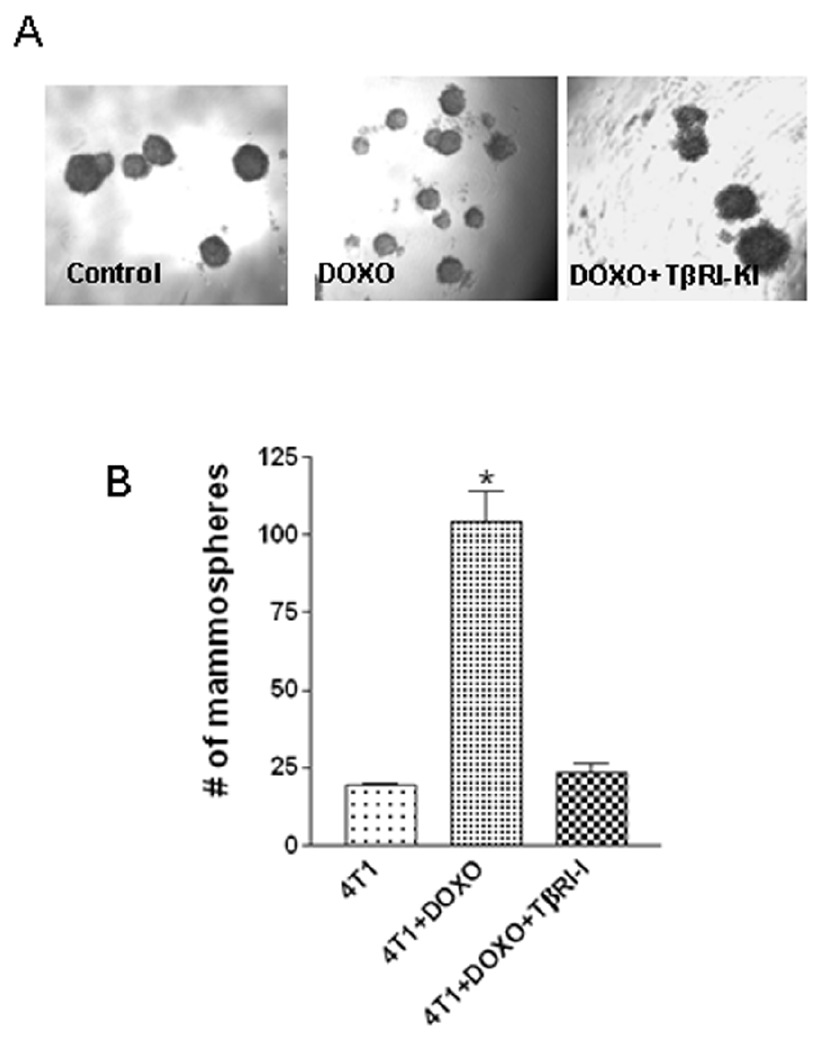
Figure 5. Abrogation of doxorubicin induced mammosphere formation by T b RI-KI. Murine 4T1 cells were treated with doxorubicin (25 nM) in the presence or absence of TbRI-KI for 6 days. The cells with or without treatment were harvested after trypsinization and filtered through 40 m m strainer to obtain a single-cell suspension. Cells were seeded (1,000 cells/100 m l/well) in a 96-well ultra-low attachment plate (Costar) and mammospheres were counted after 7 days of incubation. A. Representative pictures of mammospheres obtained from cells with or without doxorubicin treatment and also after doxorubicin treatment in the presence of TbRI-KI. B. The number of mammospheres obtained from 1,000 cells in triplicate wells with or without treatments were counted and expressed as mean 6 SEM. ‘‘*’’ indicates significant difference from the control value, P , 0.05.